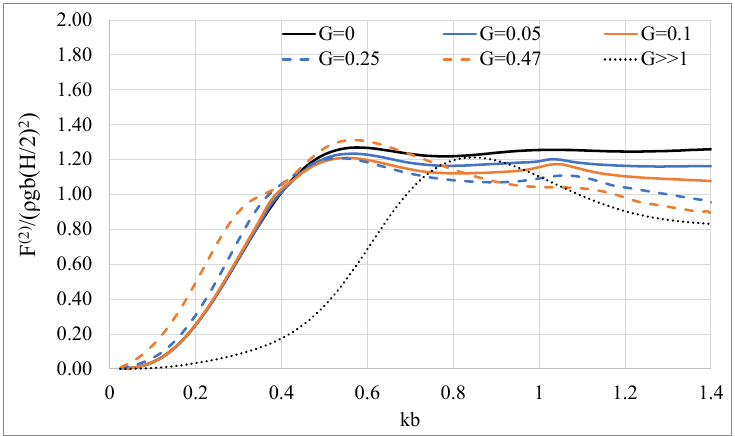
Figure 13. Effect of the porous coefficient 𝐺 on the mean drift forces on a floating porous compound cylindrical body.